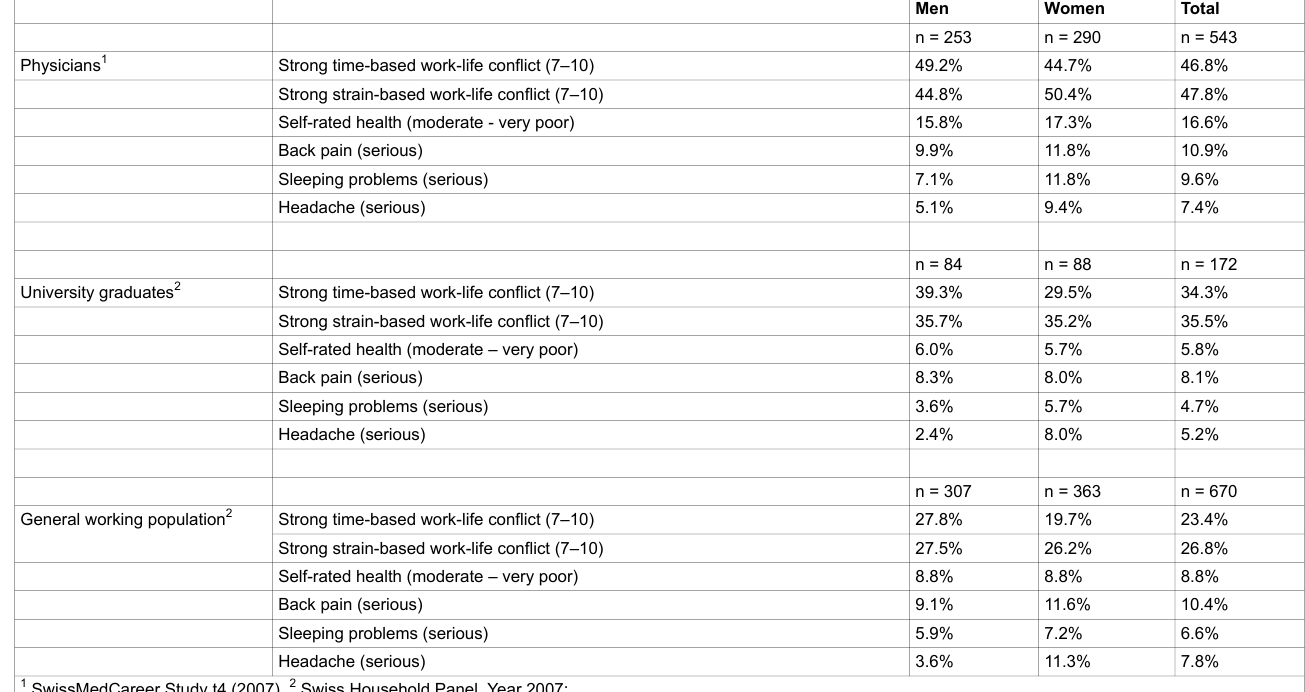
Table 2 Percentage of persons with strong time- and strain-based work-life conflict (values: 7–10) and percentage of persons with moderate to very poor health and serious health complaints ( back pain , sleeping problems , headache ) for physicians, university graduates and the general working population, stratified for gender and in